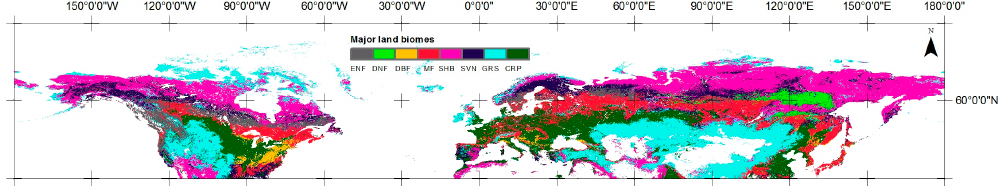
Figure 1. Major land biomes of mid- and high-latitudes of the NH aggregated from MODIS MCD12C1 global land cover product in 2001. ENF: evergreen needleleaf forest, DNF: deciduous needleleaf forest, DBF: deciduous broadleaf forest, MF: mixed forest, SHB: shrublands, SVN: savannas, GRS: grasslands, CRP: croplands. Note: SHB: including closed shrublands and open shrublands; SVN: